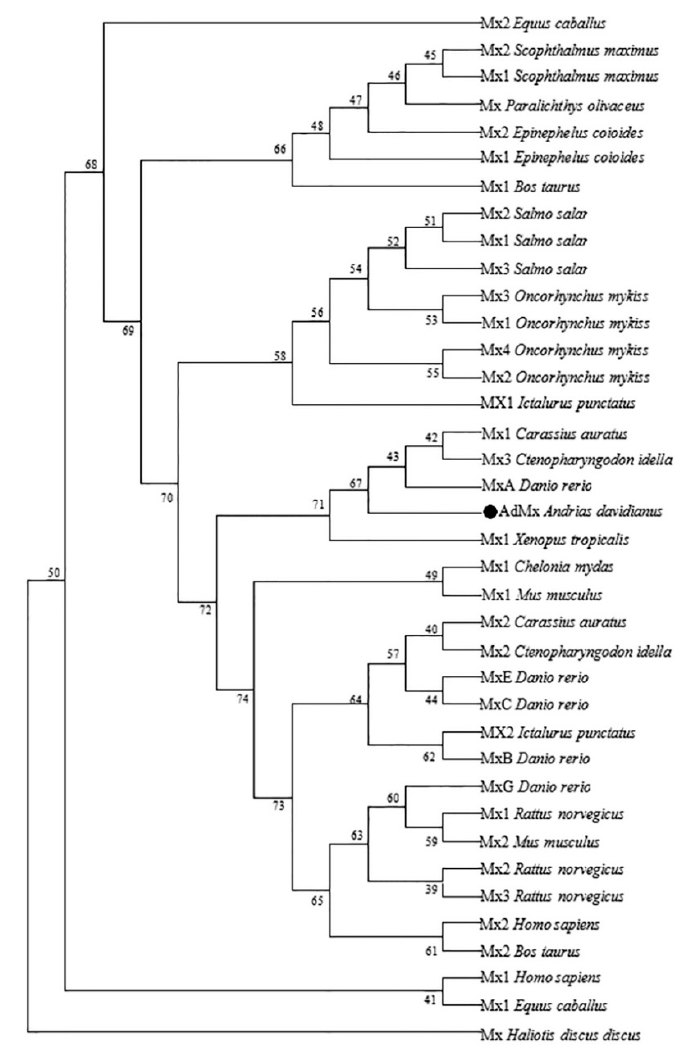
Figure 3. Phylogenetic analysis of AdMx and other Mx proteins. The phylogenetic tree was constructed with MEGA 7.0 software using neighbor-joining method. The AdMx was marked with circle ( ● ). Numbers beside the internal branches indicate bootstrap vales based on 1000 replications. Genebank accession numbers of the selected sequences are obtained from National Center of